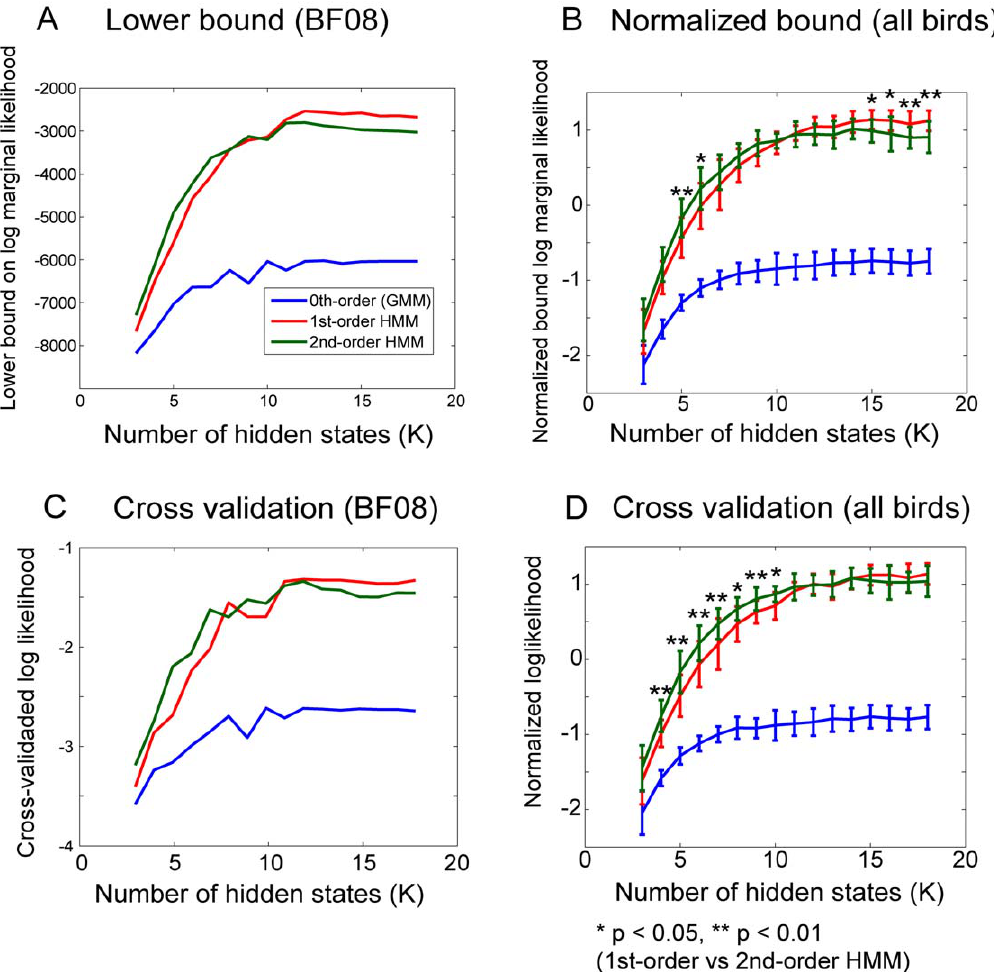
Figure 2. Comparison of statistical models with various states K and model orders on acoustic features of Bengalese finch song. (A- B) Plot of lower bound on marginal log likelihood. Larger this bound, the more appropriate model is for representing given data. For both cases, first- order HMM gave largest bound provided there was sufficient number of states available. (C-D) Cross validated log-likelihood on test data sets obtained from same bird on same date but ten different bouts from those used for training model. (A,C): representative bird (BF08). (B, D): average over all birds on normalized value. Error bars indicate standard deviation. doi:10.1371/journal.pone.0024516.g002 POMM representation (Figure 1C). The first-order HMM